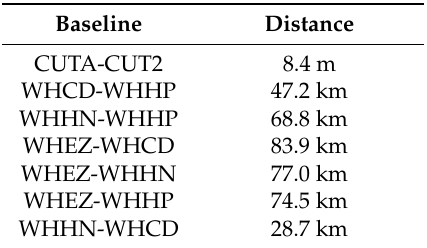
Table 6. Baseline information.